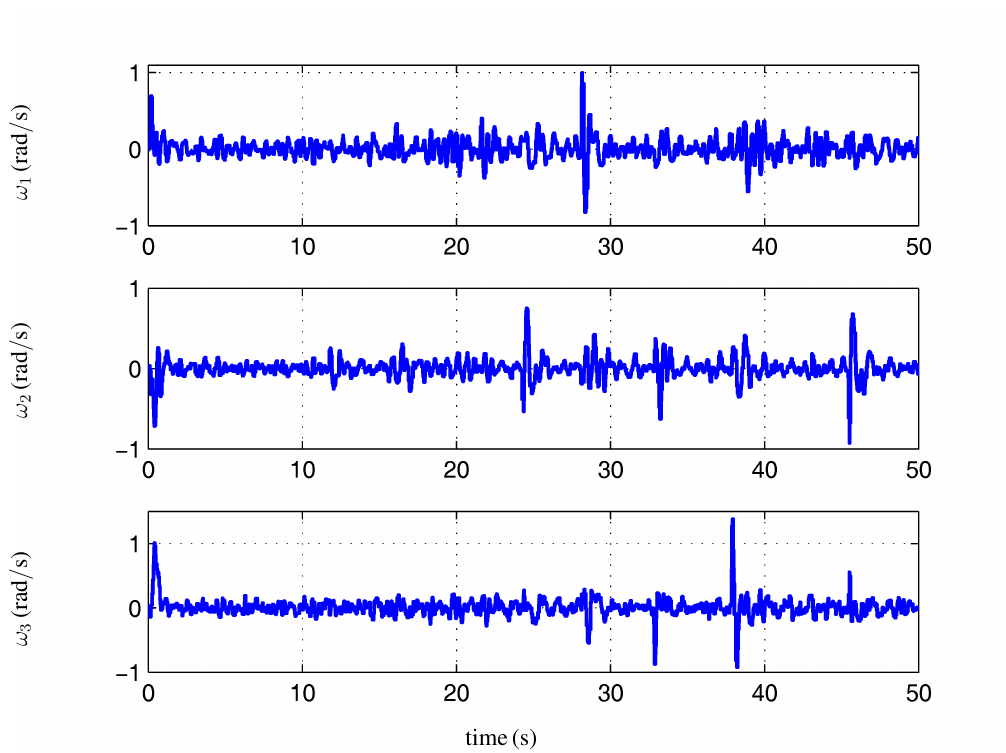
Figure 7. Control law of Corollary 1: the evolution of the body’s angular velocity.